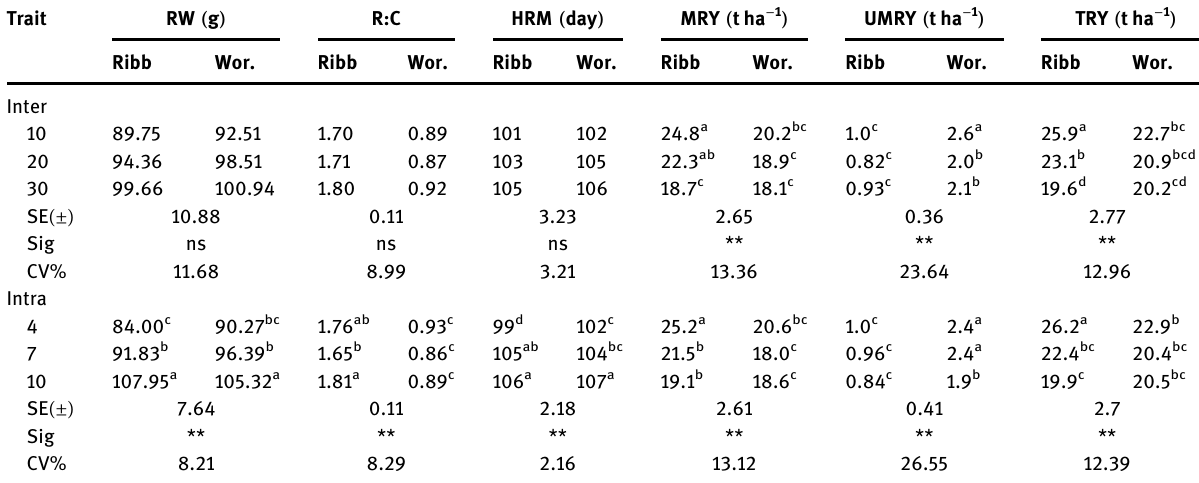
Table 4: Interaction e ff ects of spacing by location on yield, yield components, and days to maturity of carrot as combined over years Trait RW ( g )